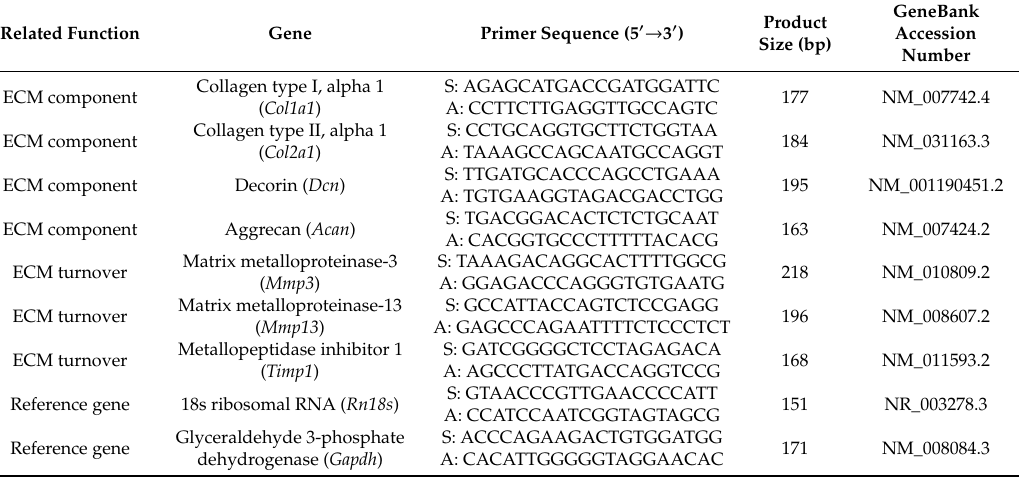
Table 1. Primers of reference and target genes used in real-time PCR.